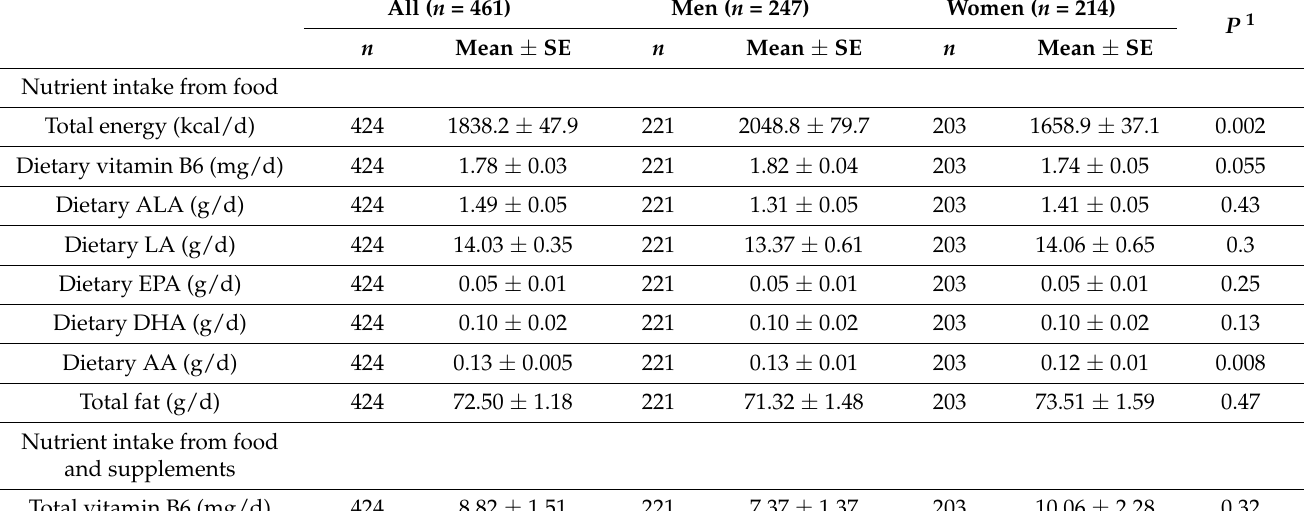
Table 2. Distributions of energy-adjusted vitamin B6 and PUFA intakes and plasma PUFA and PLP concentrations by gender among US adults aged ≥ 60 years, NHANES